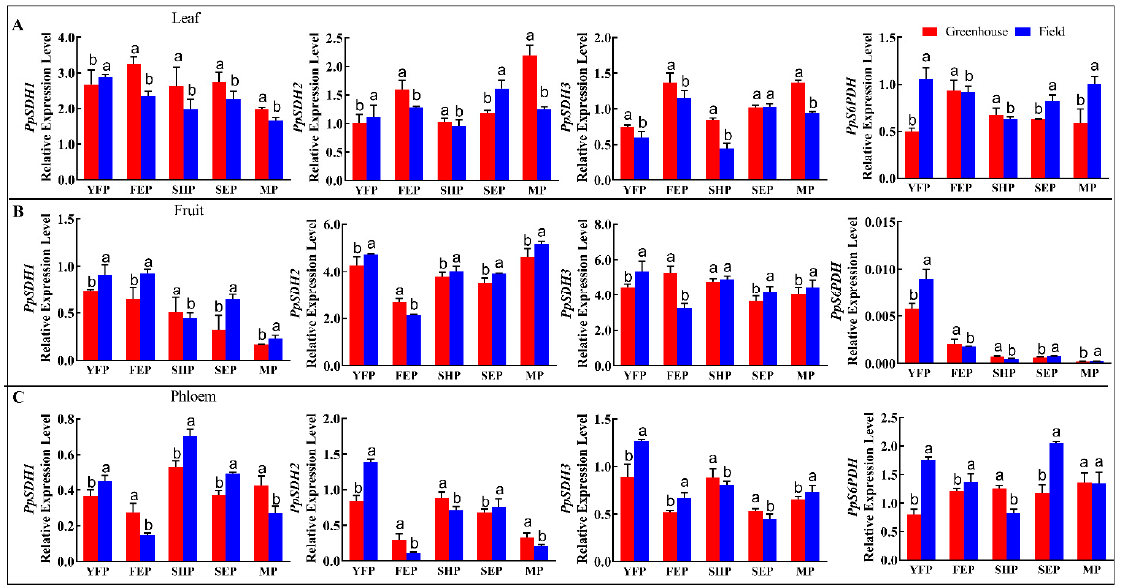
Figure 10. Expression levels of genes involved in sorbitol metabolism in different parts of peach trees grown in the field and greenhouse. ( A – C ) show the expression levels of sorbitol metabolism-related genes in leaves, fruits and phloem, respectively. The data are presented as the means ± SDs from three biological replicates. Different lowercase letters indicate significant differences ( p < 0.05).